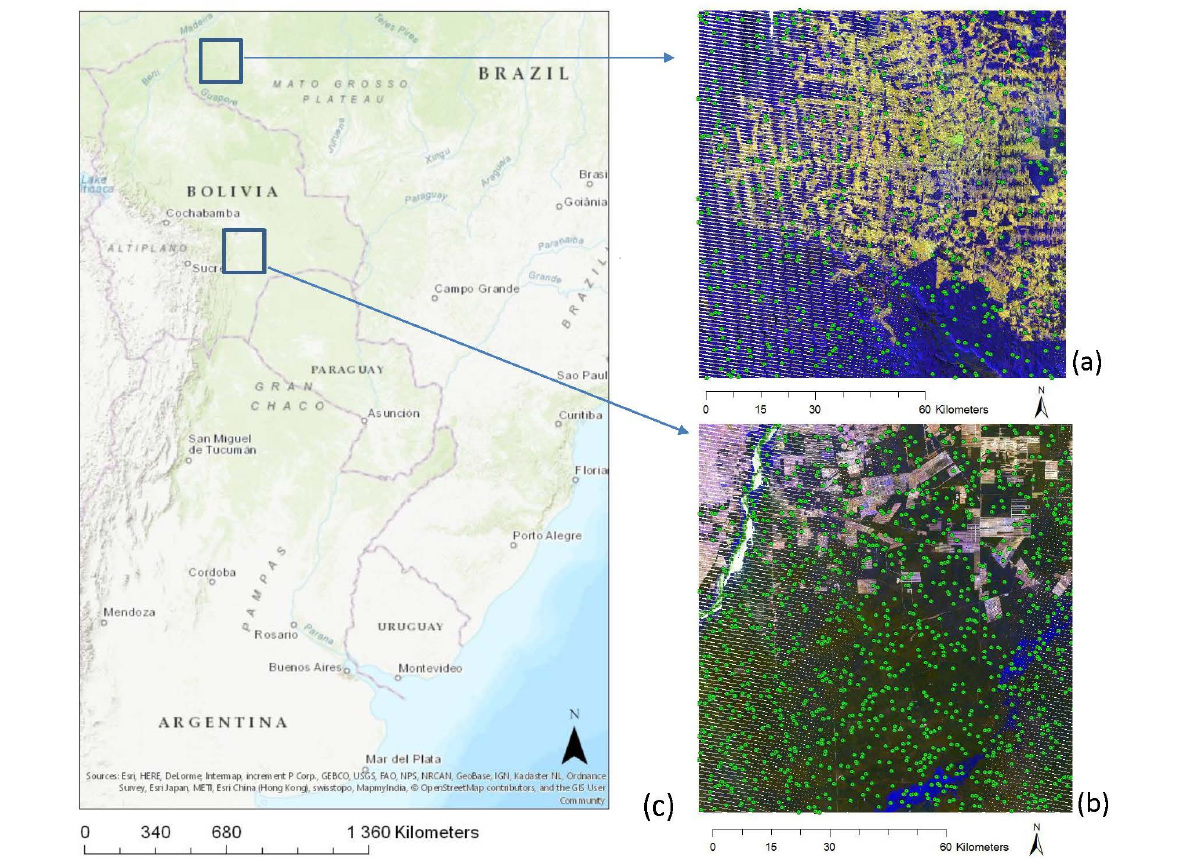
Figure 1. Map of the study area and validation points, using Landsat ETM + image Bands 3, 4 and 5 in red, blue and green channels, respectively, to composite the images. ( a ) Brazilian site; the composite image is for 22 July 2011; green circles indicate validation points; ( b ) Bolivian site; the composite image is for 7 August 2011; green circles indicate validation points; ( c ) locations of the two study